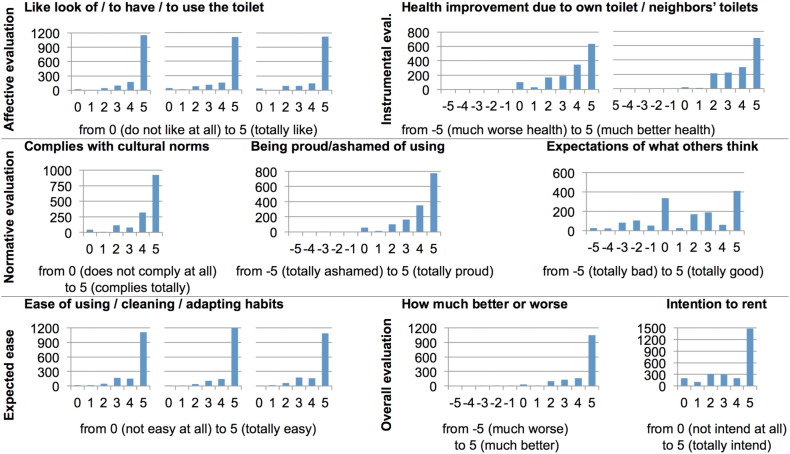
Frequencies of answers given to the closed questions by the survey sample. Note: Higher values represent a more favorable overall evaluation of the toilet.